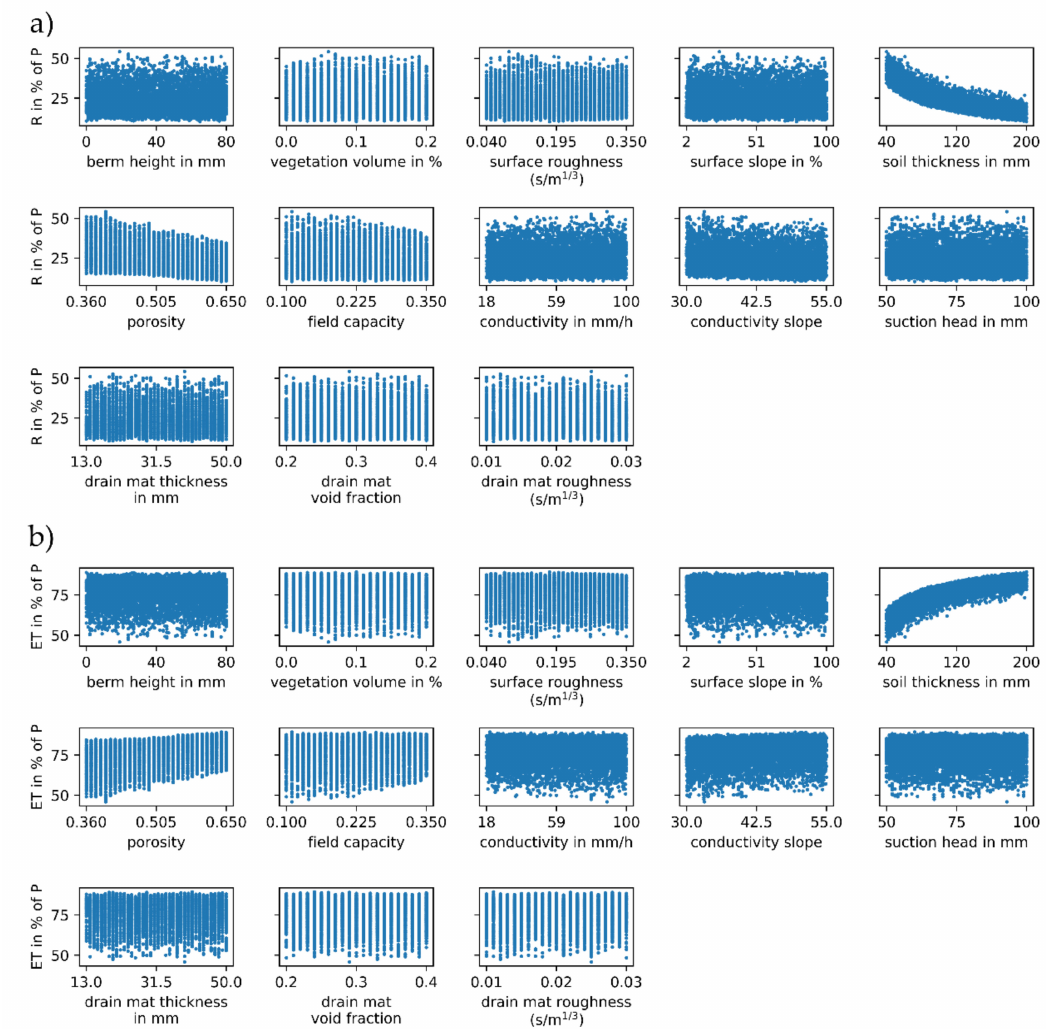
Figure 3. Results of the long-term simulations for the green roof depending on the value of the 13 green roof parameters. Each dot illustrates the result of a parameter sample. ( a ) Runoff volume (R); ( b ) evapotranspiration